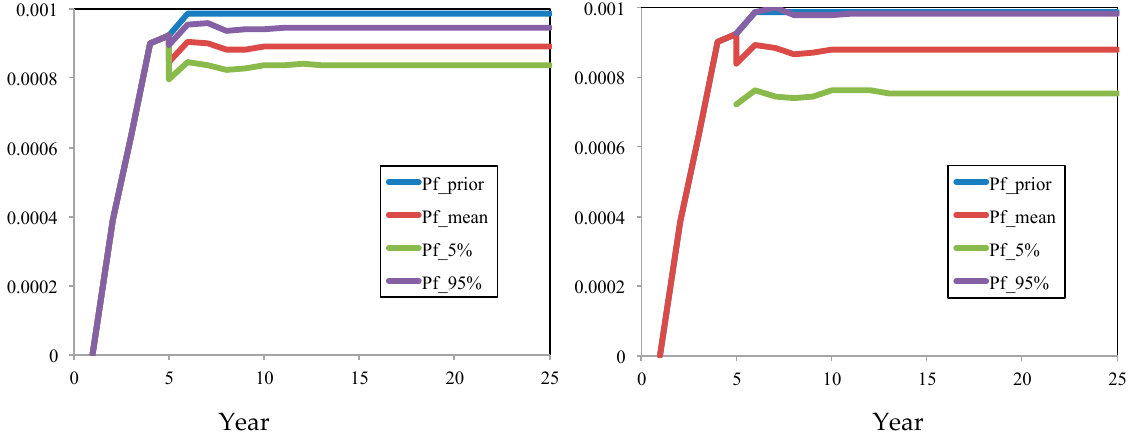
Figure 8. Updated probability of failure with: ( left ) 20 inspection data at 5 years and ( right ) 5 inspection data after 5 years.